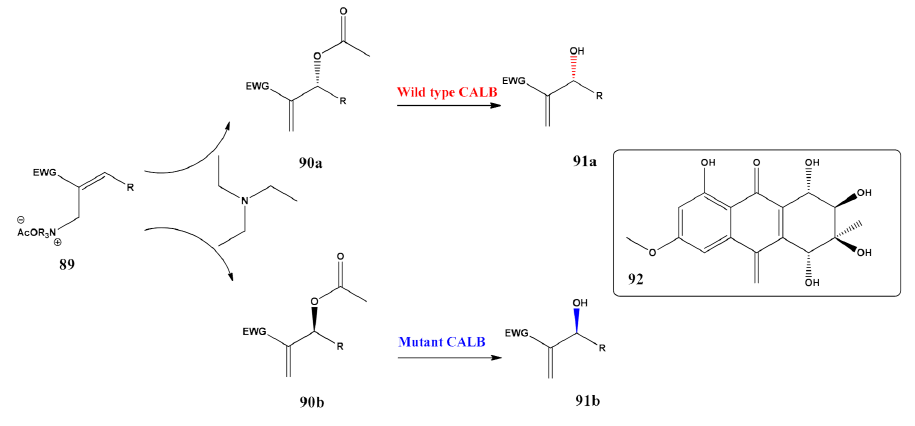
Scheme 22. Engineered lipase mediated co catalysis for dynamic kinetic